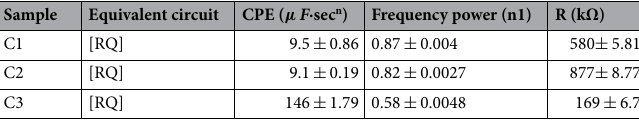
Table 4. Impedance values obtained from equivalent circuit fitting.